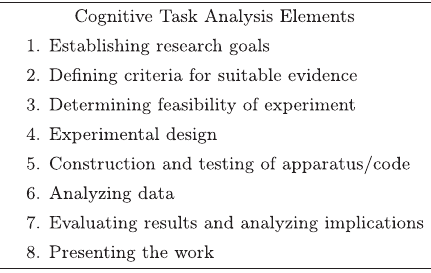
FIG. 1. List of EPCTA elements from Ref. [9]. Each task element contains a number of subtasks and there is extensive iteration between tasks and subtasks, as well as cycling back to earlier elements. Note that element seven combines two tasks from the original